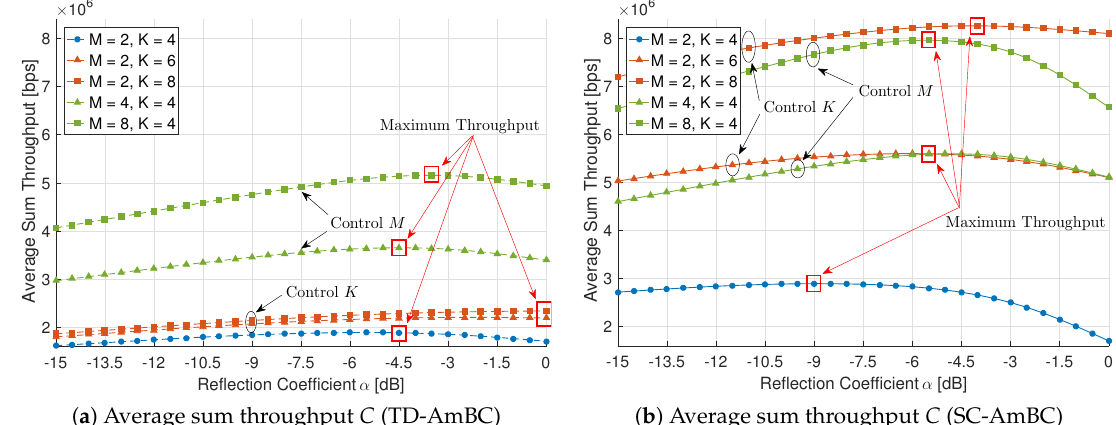
Figure 11. Effect of the reflection coefficient α ( L + =